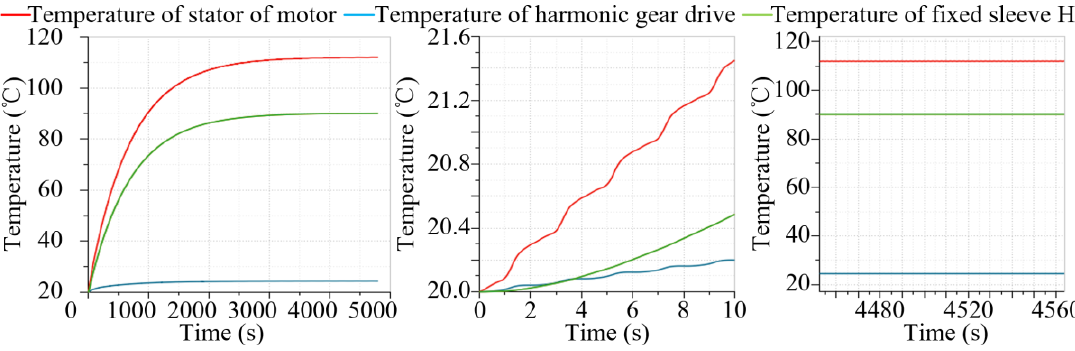
Figure 12. Variation of temperature of parts and components over time.